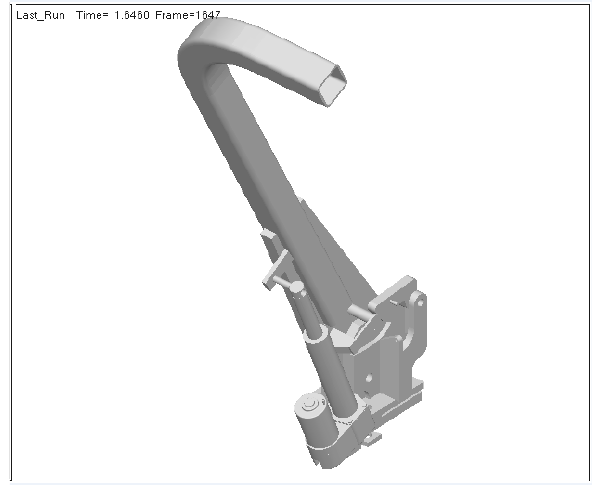
Figure 10. Three-dimensional model of the system used for the dynamic simulation.